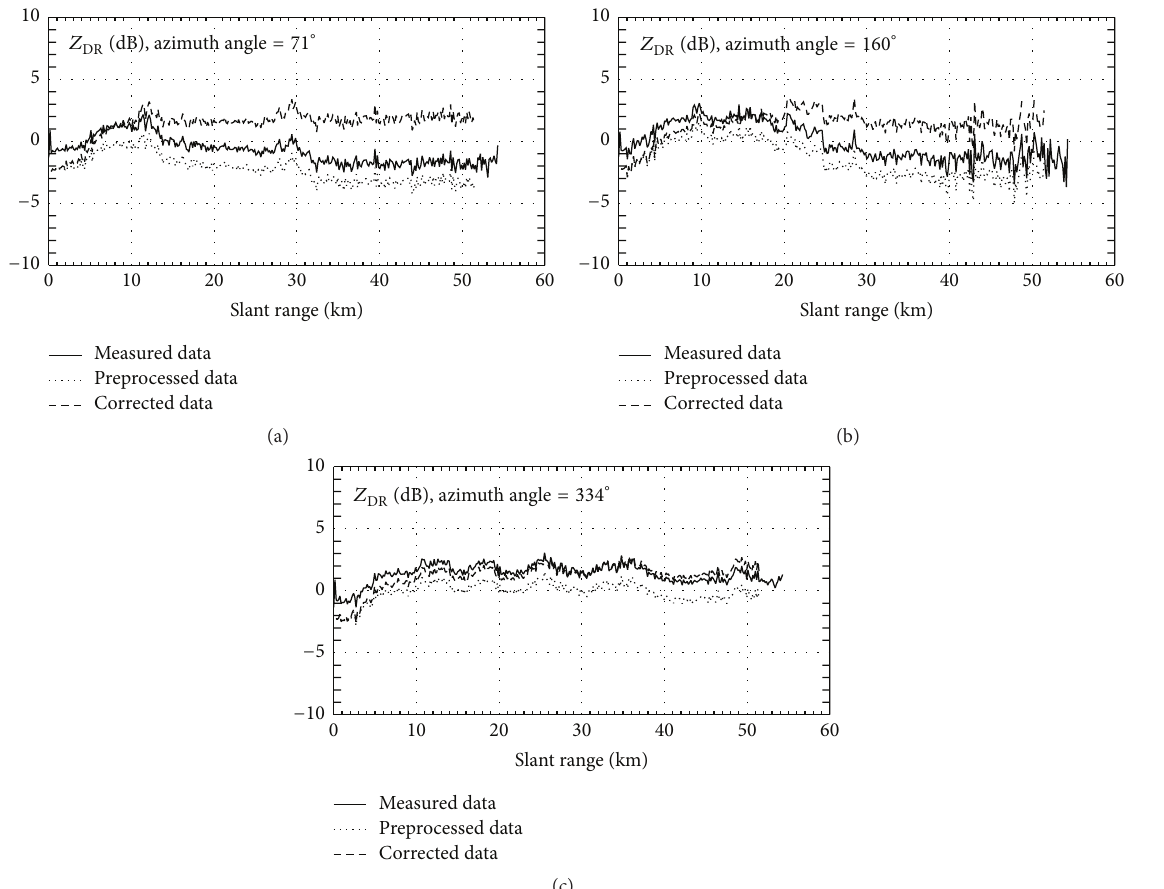
Figure 10: Range profiles of measured (line); calibration bias, 𝜌 at 71 ∘ (a), 160 ∘ (b), and 334 ∘ (c) azimuth angles of NIMS-XPOL for the case in Figure (dash) 𝑍 DR